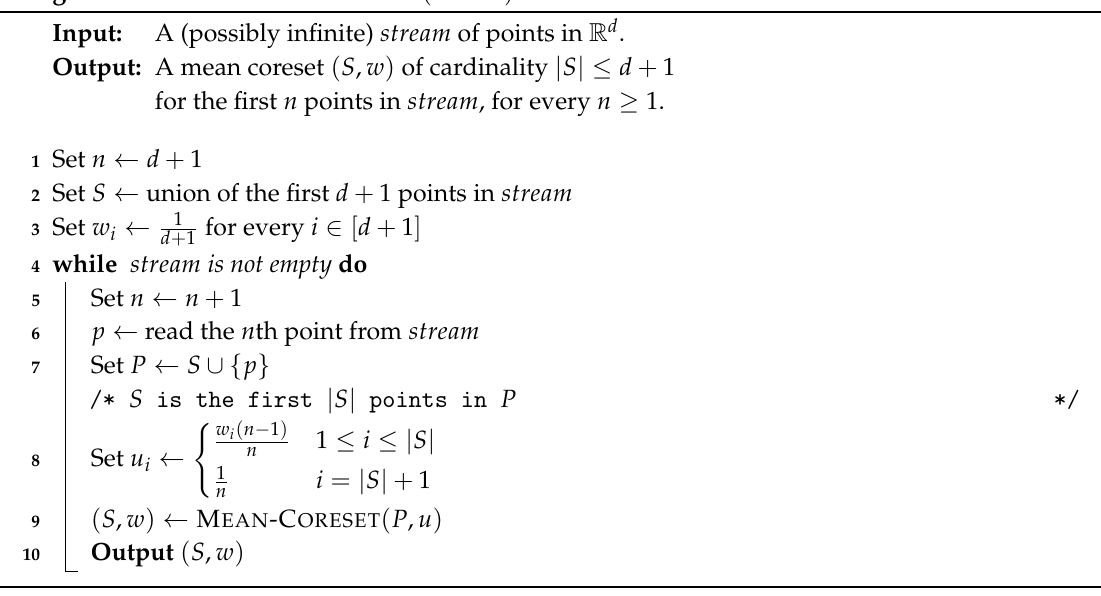
Algorithm 2: S TREAMING -C ORESET ( stream